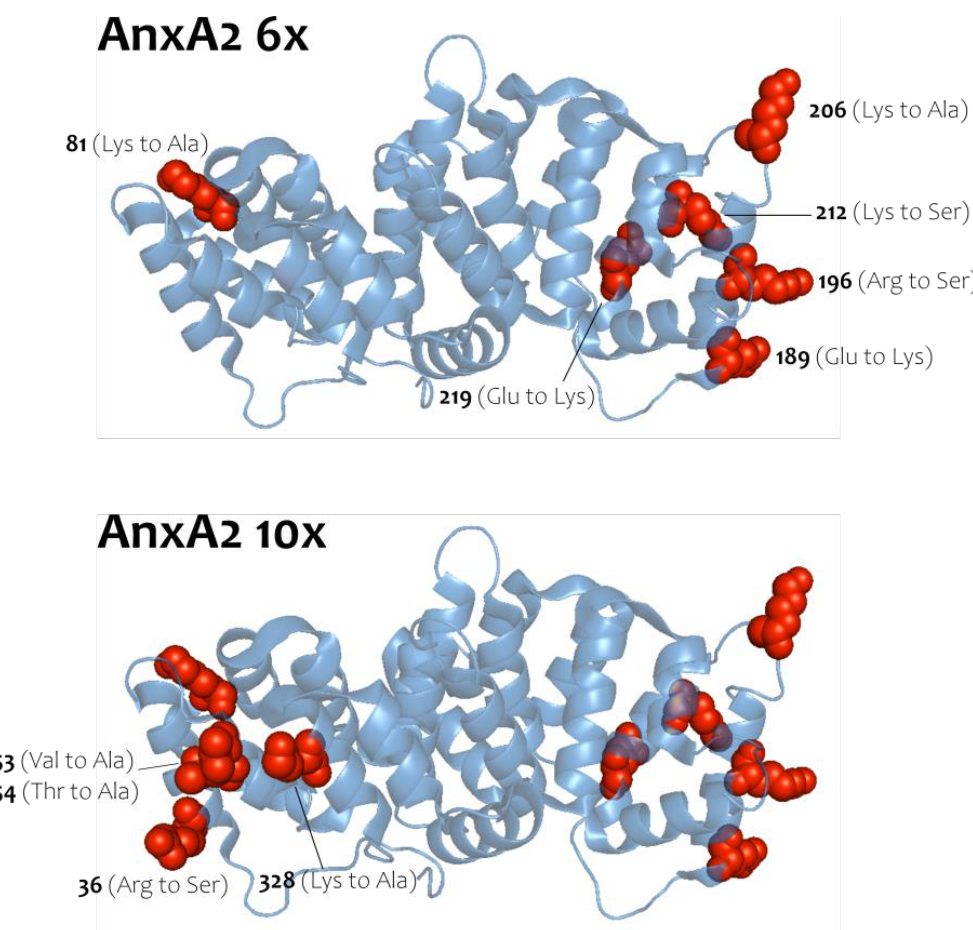
Figure 3. AnxA2 crystal structure highlighting mutations introduced in the AnxA2 6x and 10x constructs. AnxA2 6x top [81 (Lys to Ala), 189 (Glu to Lys), 196 (Arg to Ser), 206 (Lys to Ala), 212 (Lys to Ser) and 219 (Glu to Lys)] and AnxA2 10x bottom [36 (Arg to Ser), 53 (Val to Ala), 54 (Thr to Ala) and 328 (Lys to Ala)]. Illustrations were created using the AnxA2 crystal structure (PDB code: 1XJL).